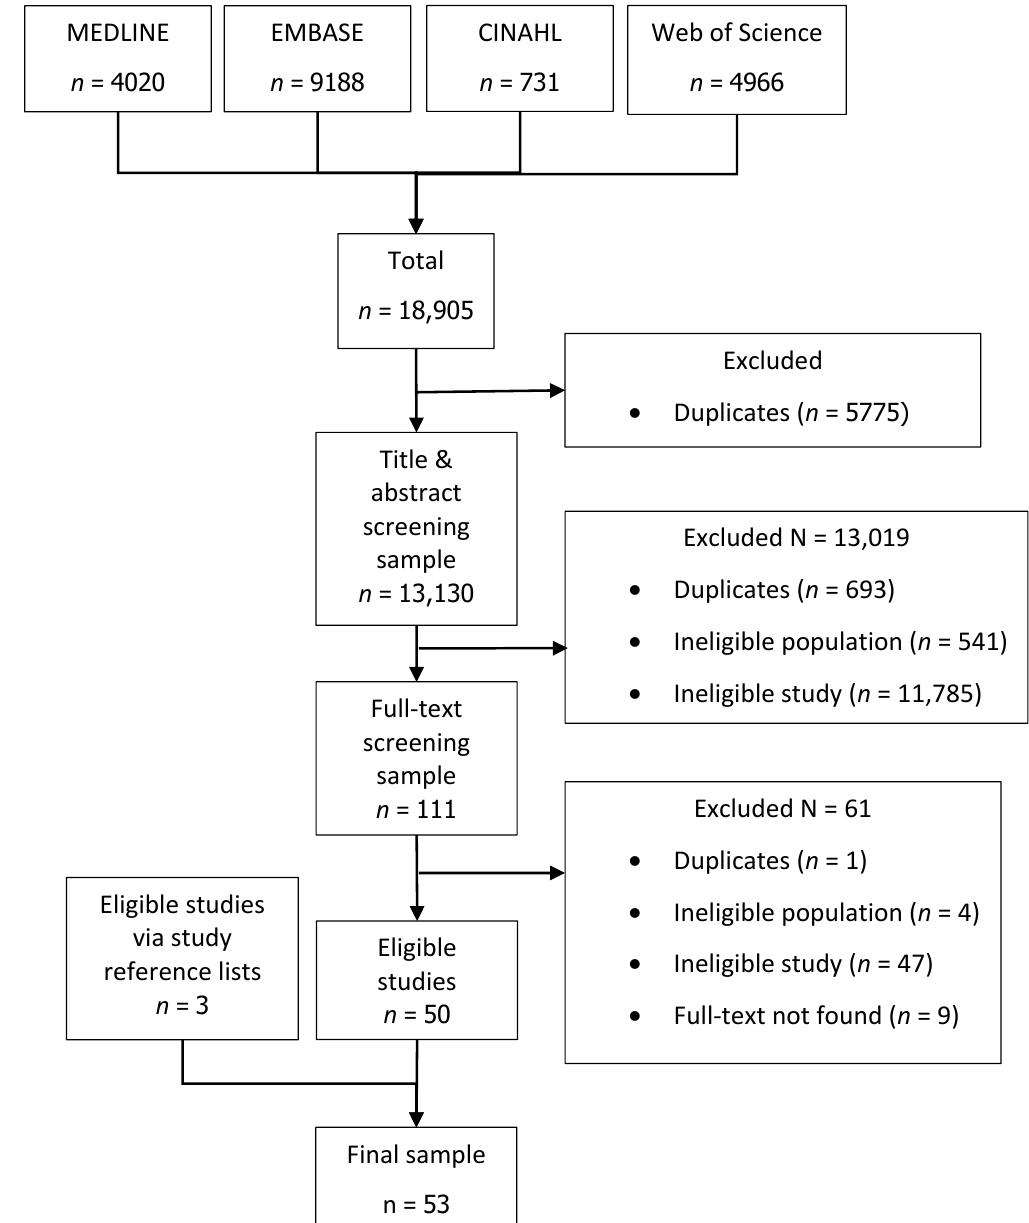
Figure 1. PRISMA diagram. The 53 eligible articles were published between 1995 and 2019, with the majority (55%, n = 29) published in the last five years (2015–2019).